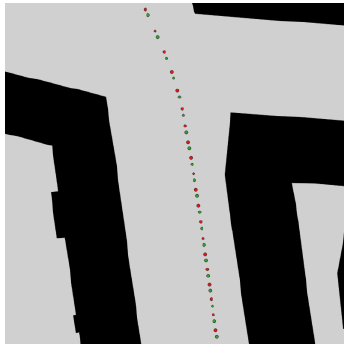
Figure 8. Trajectories. The reference feature point dataset was generated from the red trajectory, the current feature point dataset from the green trajectory